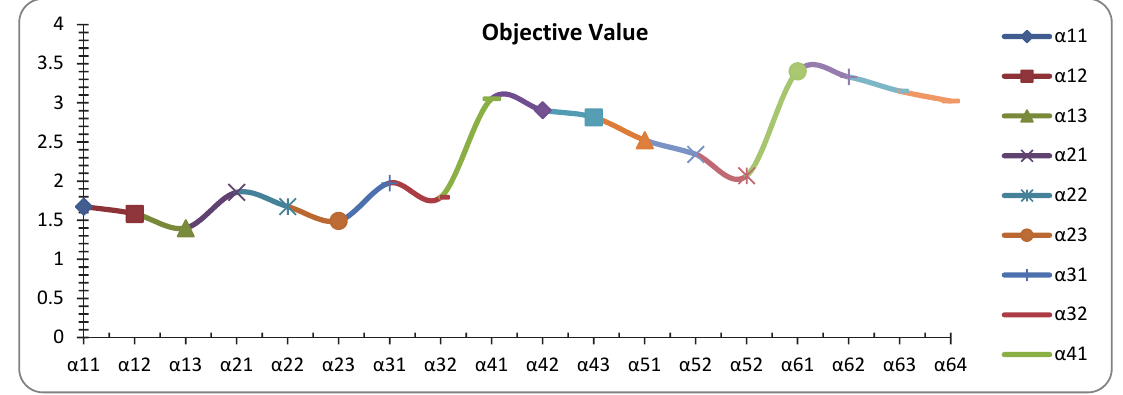
Fig. 3. Objective